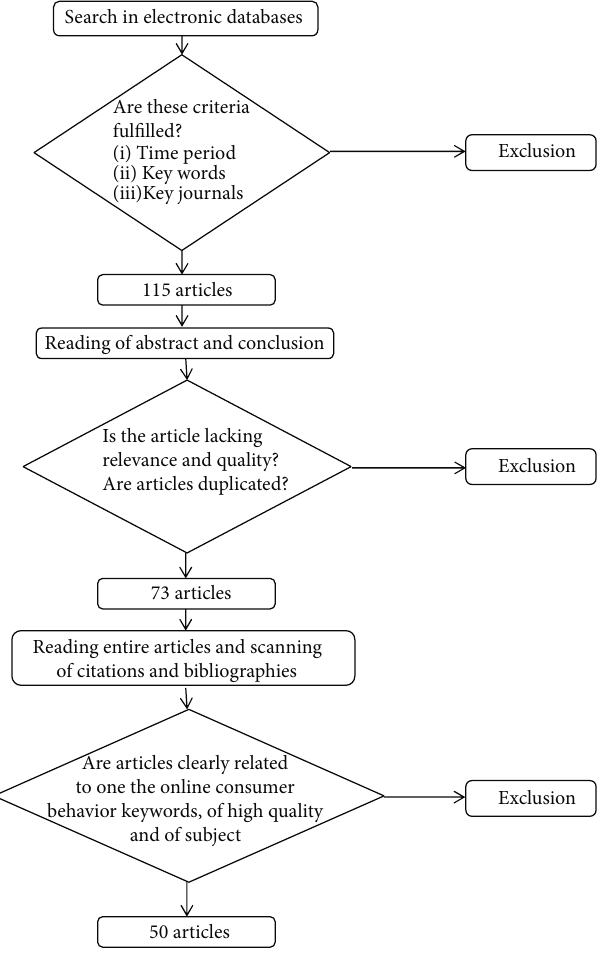
Figure 1: Summary of article selection process. Source: Adapted from Yong et al. [147].